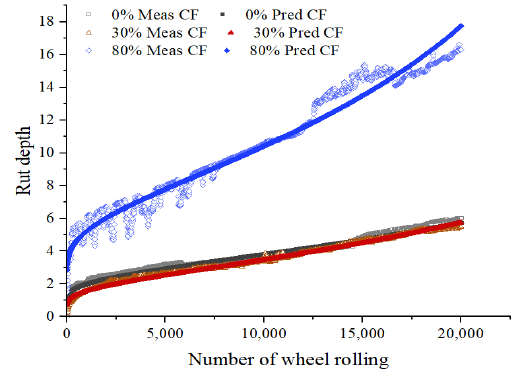
Figure 20. HWTT curve of BPCF asphalt mixture. Table 10. HWTT fitting parameters of each asphalt mixture.